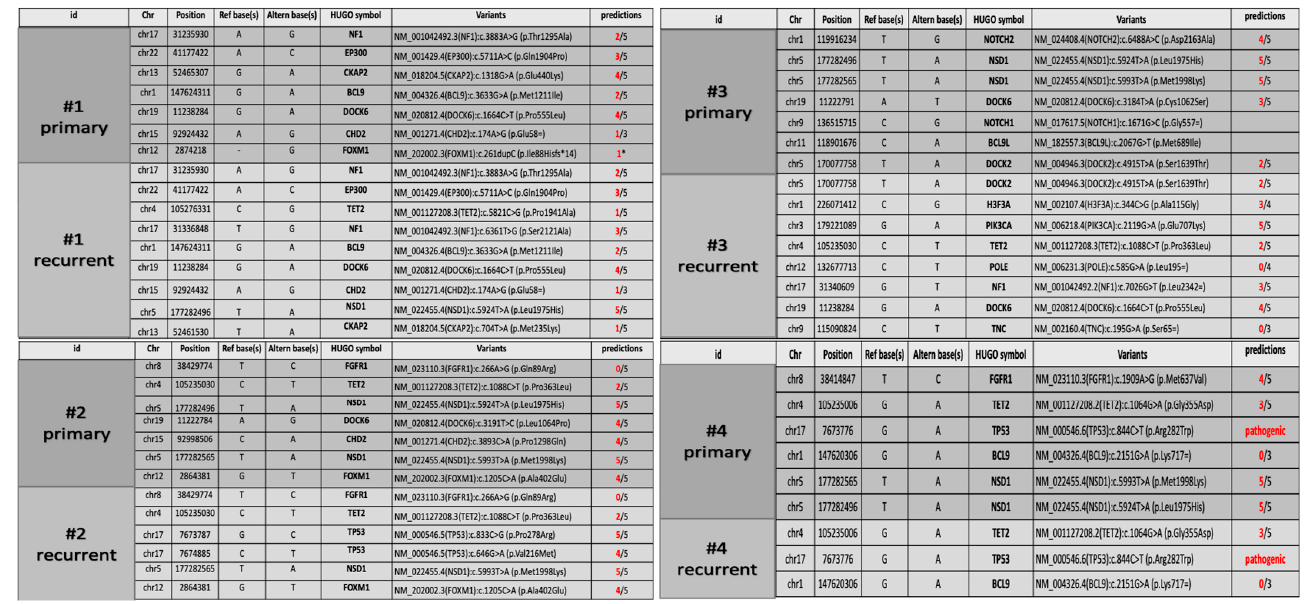
Figure 5. WES data collection. Candidate variants table from Whole-exome sequencing identified in four pairs of tumor samples of pHHGs. Only the variants with at least three out of five predictions of protein damage are shown in the table (except for the CDH2 variant c.174A > G, p.Glu58=, with a suspected deleterious effect on